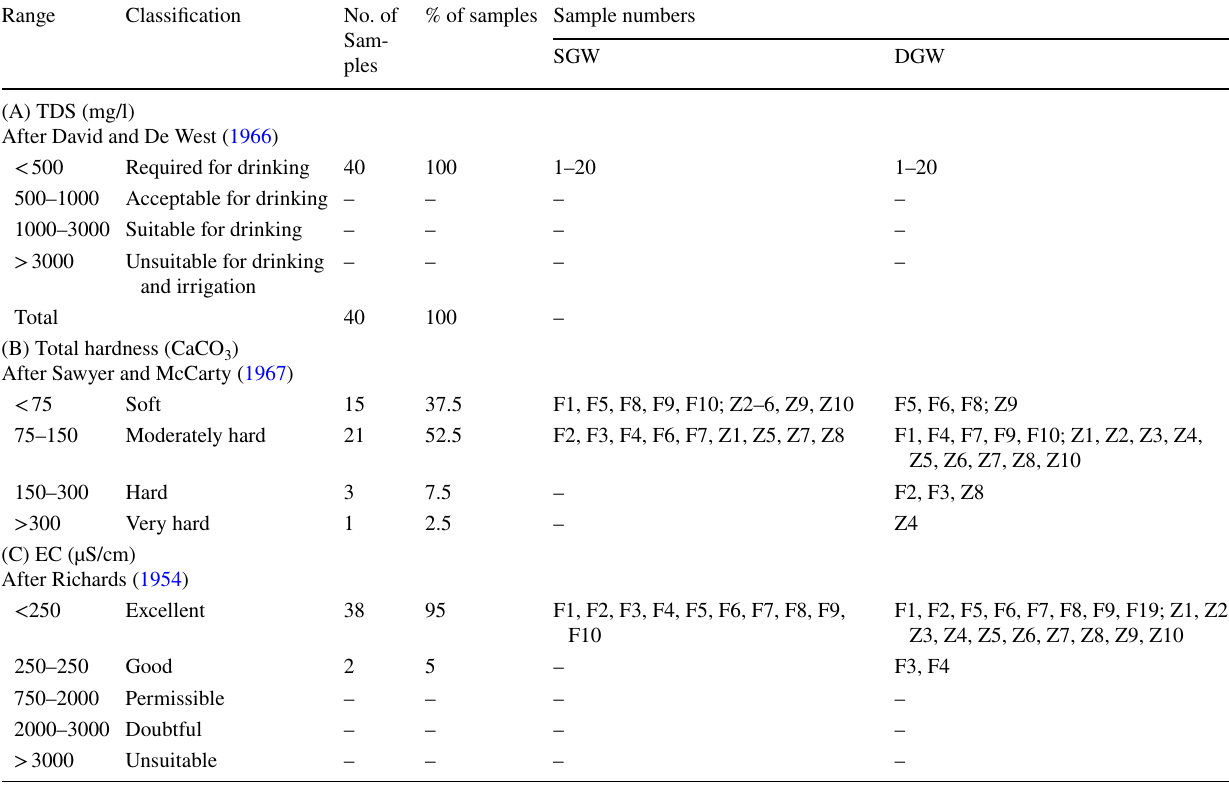
Table 5 Groundwater classification based on TDS, hardness, and conductivity